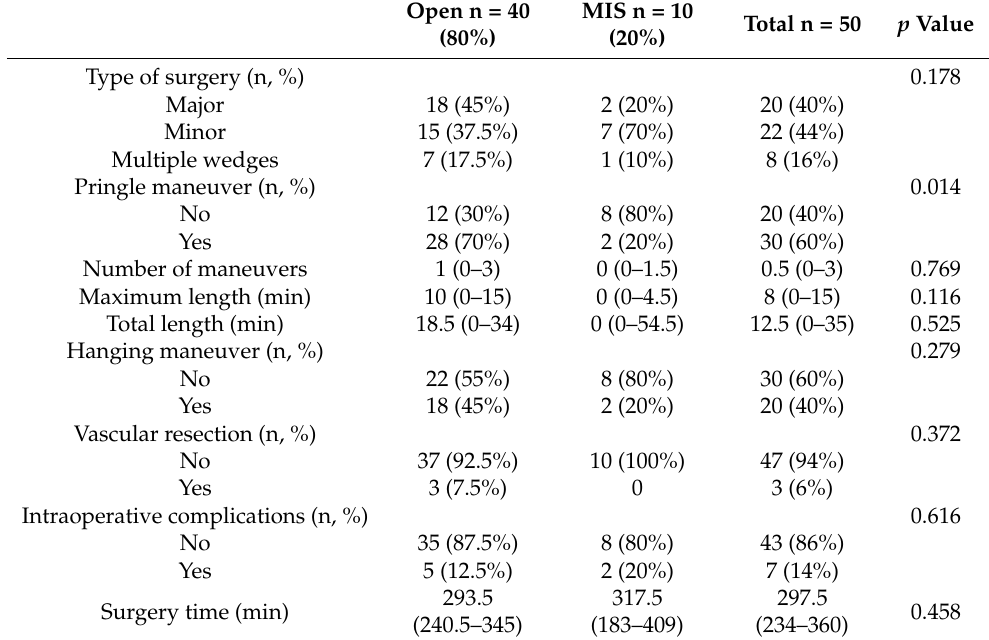
Table 3. Operative